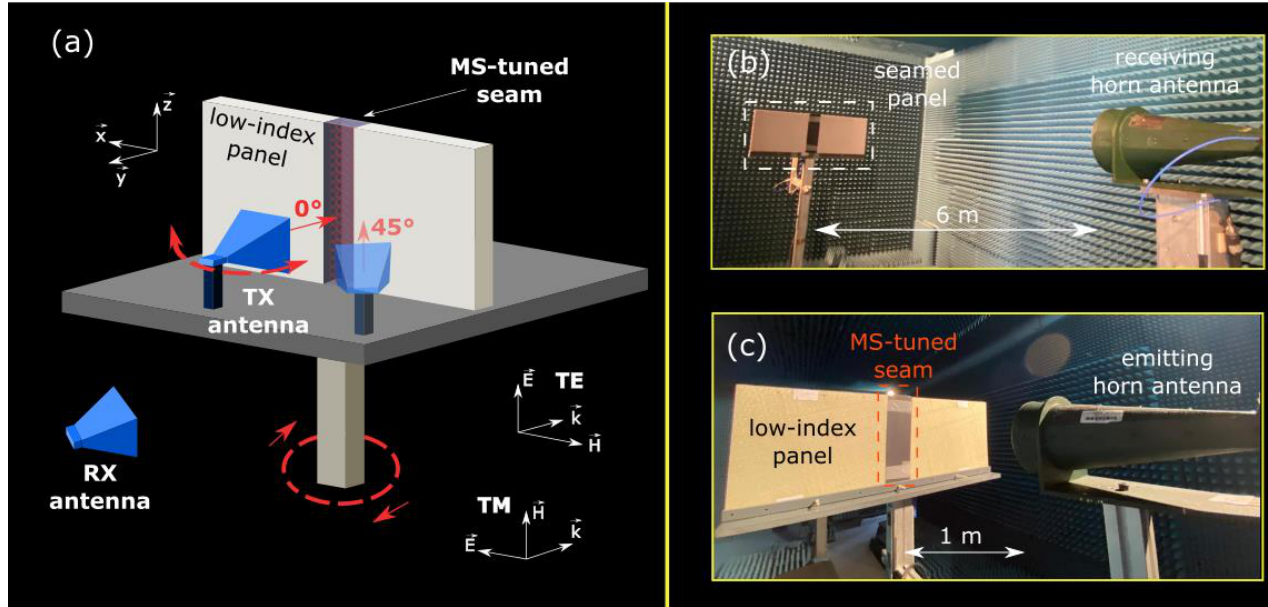
Figure 4. ( a ) Schematic illustration of the studied structure. Two low-index radome panels are connected via a high-index MS-tuned seam. The structure is illuminated by an emitting (Tx) antenna and a receiving (Rx) antenna allows us to measure the antenna radiation patterns for different angles of incidence. ( b ) Photography of the far-field measurement setup in an anechoic chamber. ( c ) Close up of the emitting antenna illuminating the seamed panel.